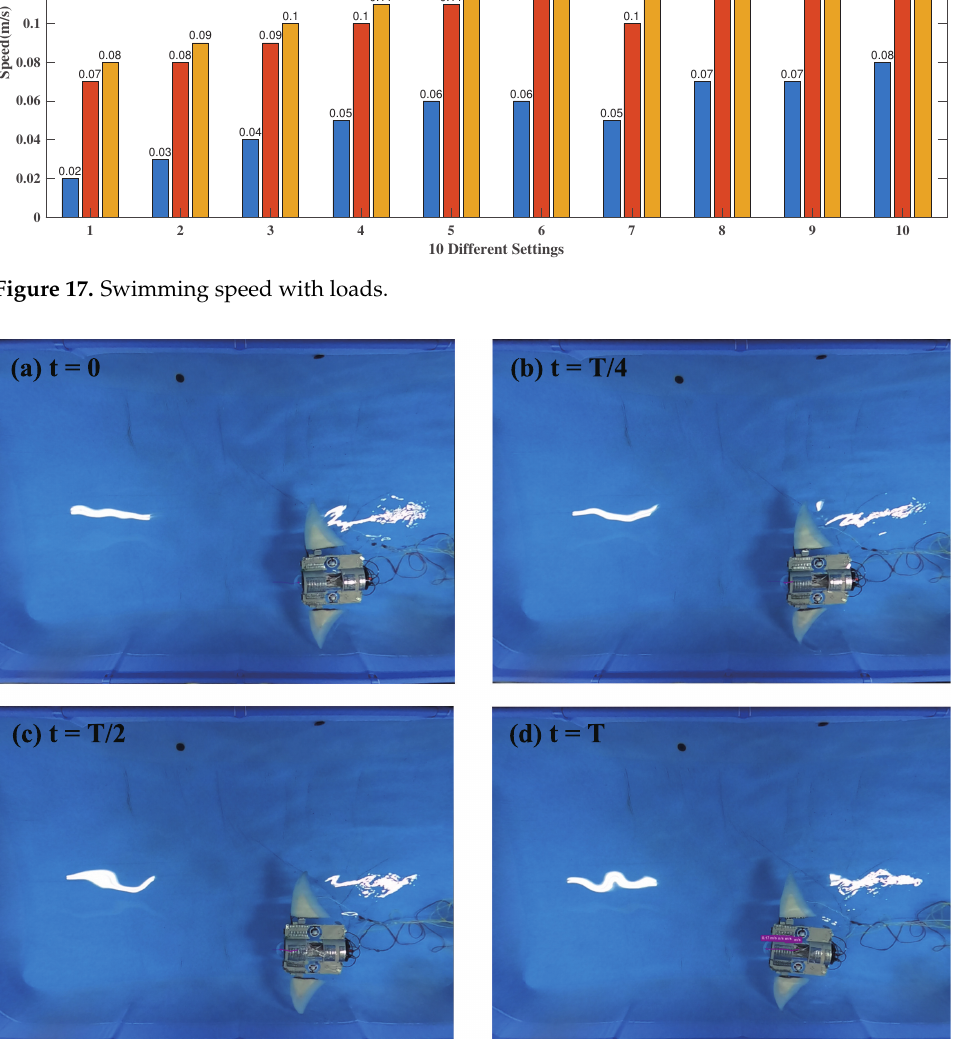
Figure 18. The experiment with load in the swimming pool, f = 0.8 Hz, φ 0 = 30, θ 0 =